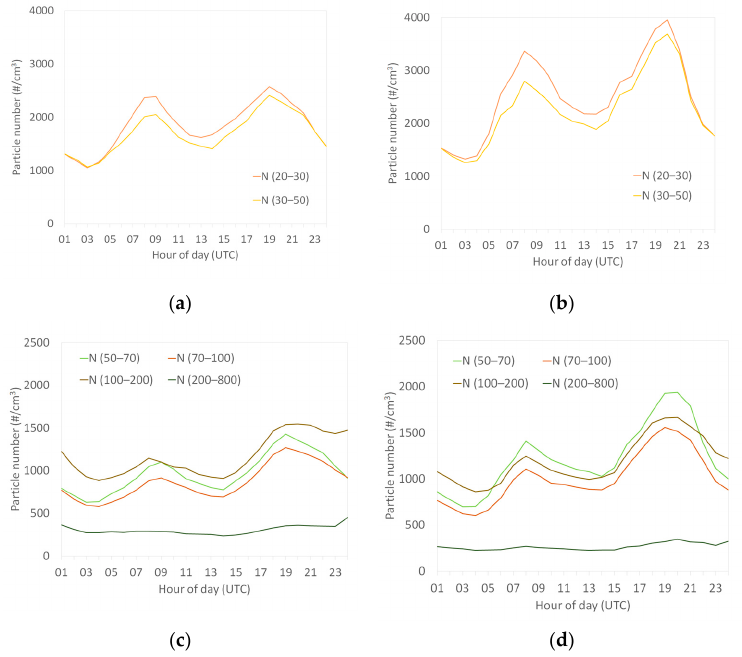
Figure A6. Average daily profiles of each size range ( a , c ) for background site and ( b , d ) for the roadside site over the measurement